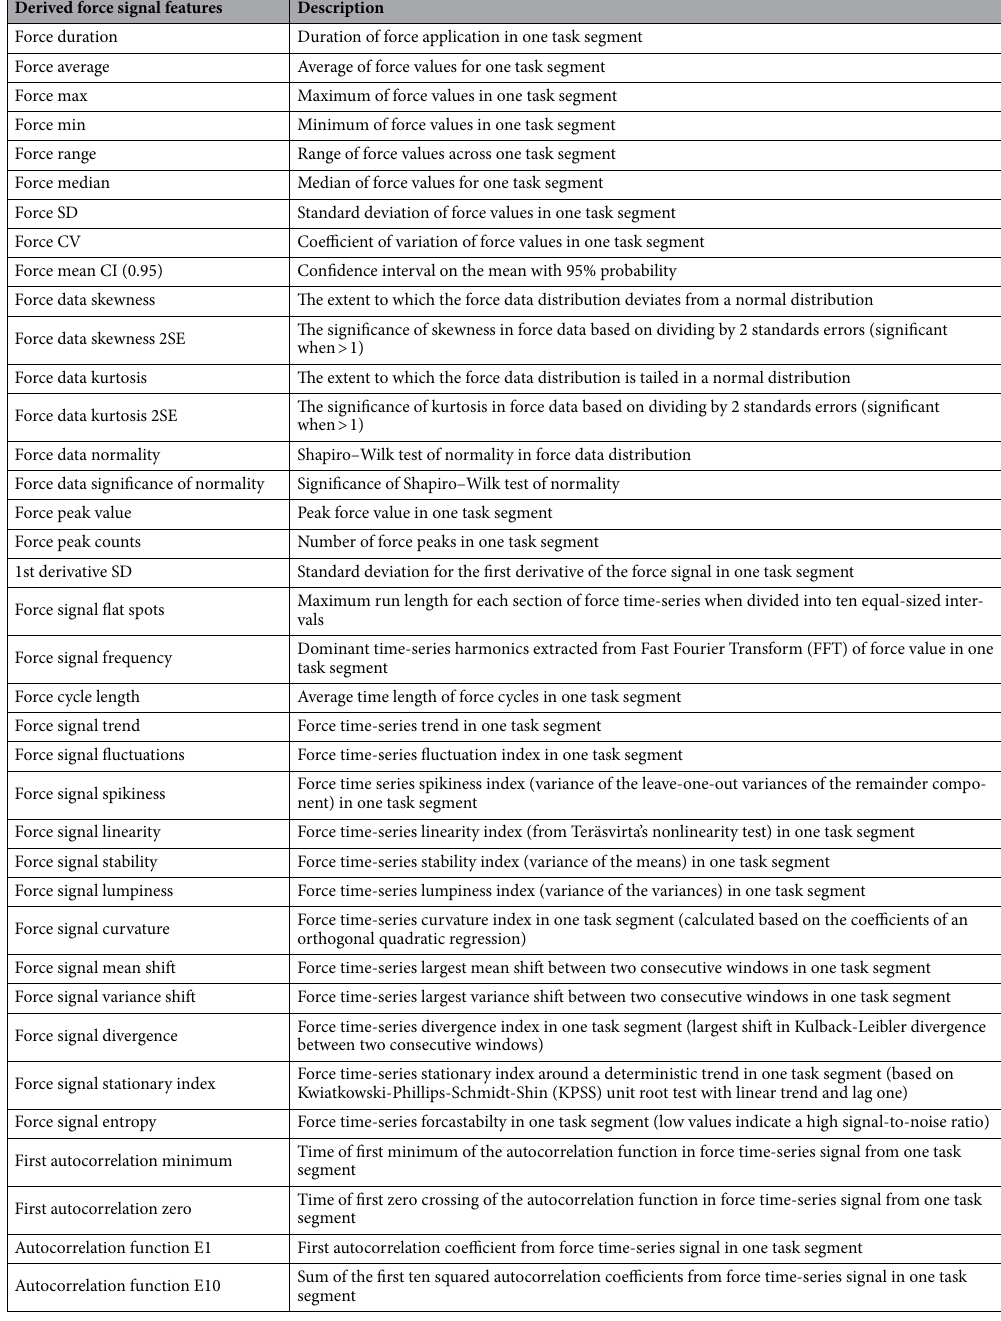
Table 1. Various features were extracted from the force signal data of each prong in SmartForceps to be used in the monitoring models for surgeon skill assessment. This table provides a full list of these time-series and statistical features along with their detailed